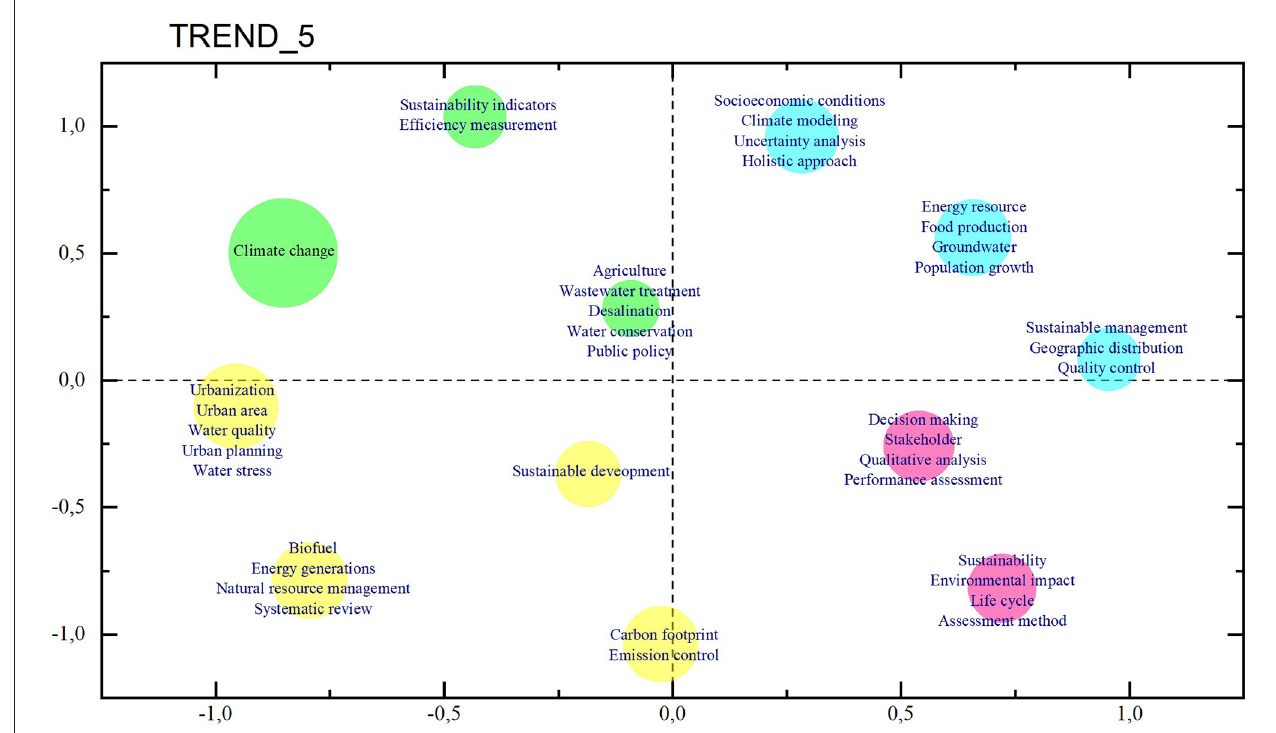
FIGURE 8 | Trend 5 key topics on WEF nexus research in the period